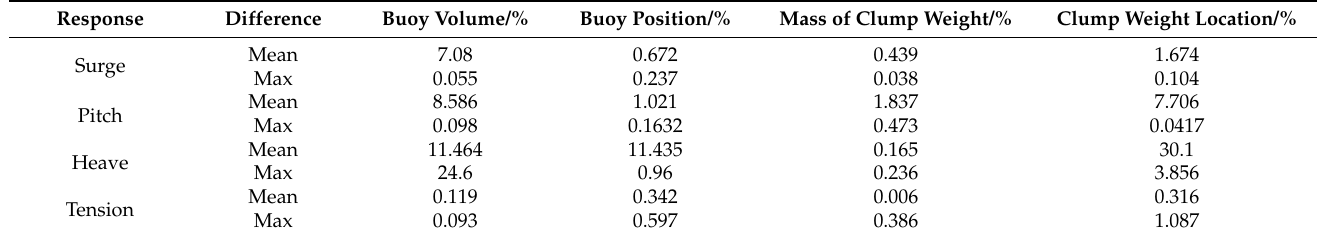
Figure 11. Comparison of improvement rate of mooring performance by changing mooring param- eters. ( a ) Comparison of surge and pitch response optimization rates under different parameters. ( b ) Comparison of heave and tension response optimization rates under different parameters. Table 7. The difference of the response lifting rate when the accessories are used separately and in